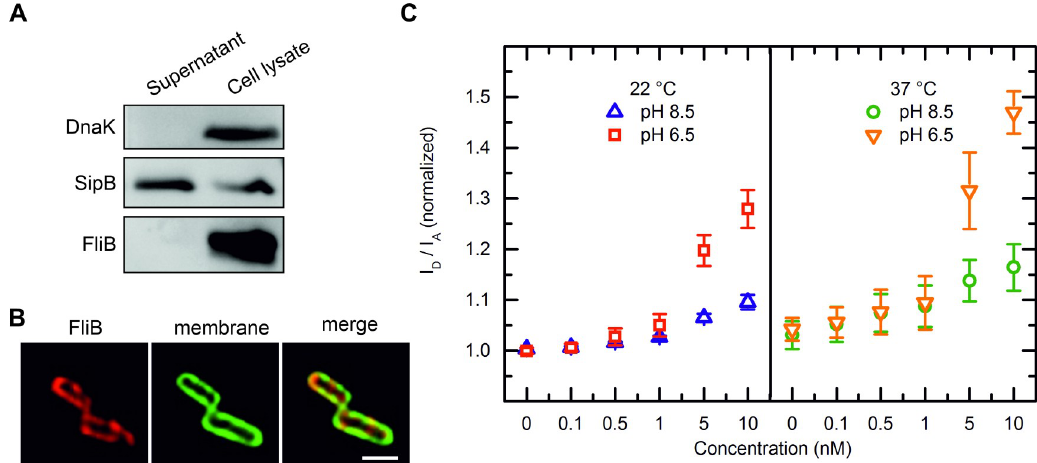
Fig 1. FliB localization. ( A ) Western blot analysis of proteins from S . enterica Typhimurium whole cell lysates and protein secreted into the growth culture. The protein DnaK served as cell lysis control and the secreted protein SipB as loading control (positive control). ( B ) High magnification micrographs showing the FliB localization in Salmonella cells. The rod-shaped Salmonella cells were visualized, FliB was detected by using an anti-strep primary antibody in combination with a secondary antibody conjugated with the Alexa 647 (red) and the cell membrane was labelled with FAST DiO lipid dye (green) (see also S4 Fig). The scale bar corresponds to 1 μ m. ( C ) FRET spectroscopy of concentration dependent ftFliB association with liposomes. Titration of ftFliB (up to 10 nM) to a PE:PG (1:1 [m:m]) liposome population (10 μ M lipid concentration) that was double labelled with NBD-PE as FRET donor and rh-PE as FRET acceptor lead to a reduced FRET efficacy. This can be derived from the fluorescence intensity ratio donor to acceptor, which is plotted against the concentration. At 22˚C, the ftFliB interaction with lipid matrix was stronger at pH 6.5 than at pH 8.5; the same relationship applied at 37˚C, with more pronounced effects at both pH. Error bars indicate standard deviations of 4 or 5 independent measurements.